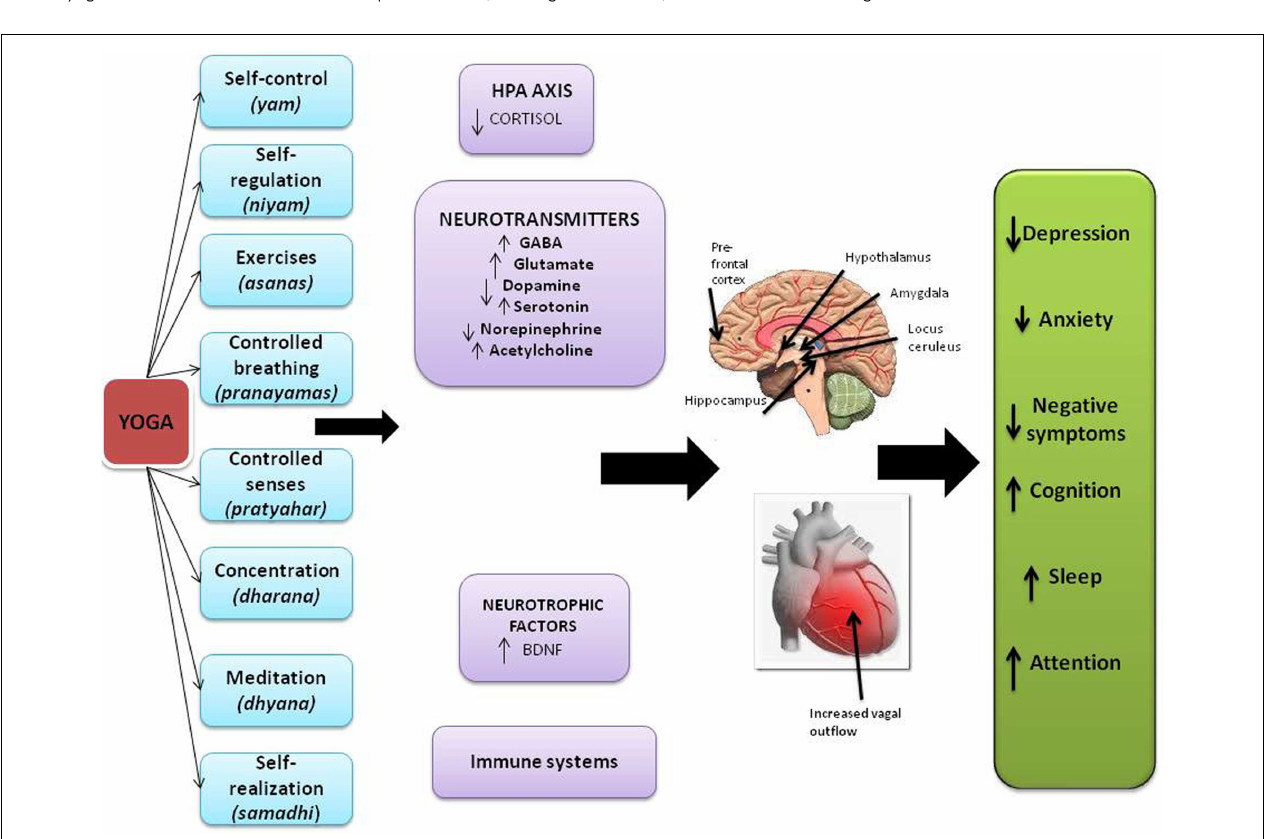
FIGURE 1 | Schematic illustration of potential effects of yoga on biomarkers and end organs based on various sources. The strength of evidence ranges from strong to preliminary for specific effects as described further in the text. Copyright Doraiswamy and Balasubramaniam, reproduced with permission in this